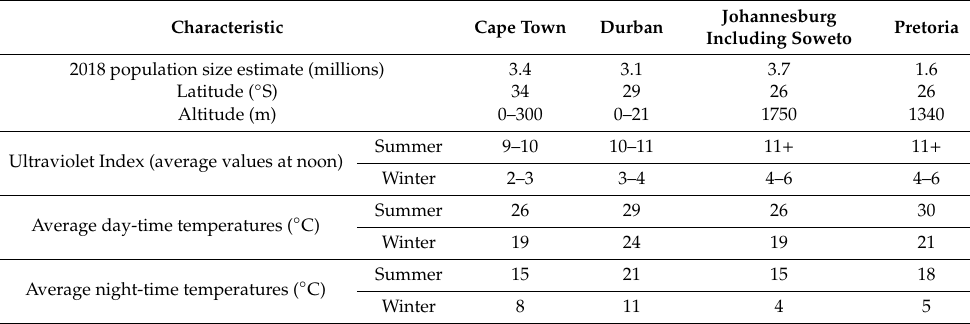
Table 2. Characteristics of the four major cities in South Africa